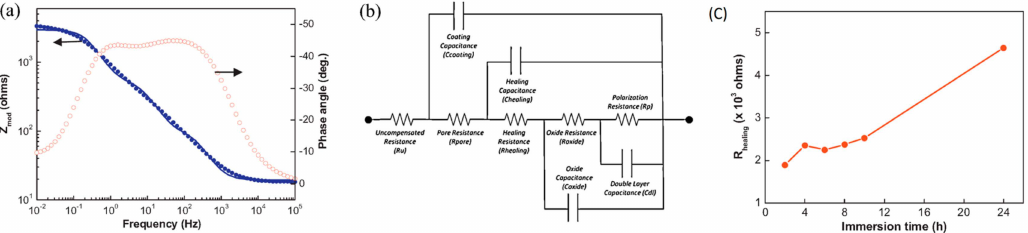
Figure 11. ( a ) Bode plots and fitted curves (solid line) of scratched epoxy coating with HDI filled PU after 8 h of immersion in 1 M NaCl solution, corresponding ( b ) equivalent circuit in EIS measurement and ( c ) healing resistances ( R healing ) versus immersion time plot. Adapted from [62], with permission from © 2014